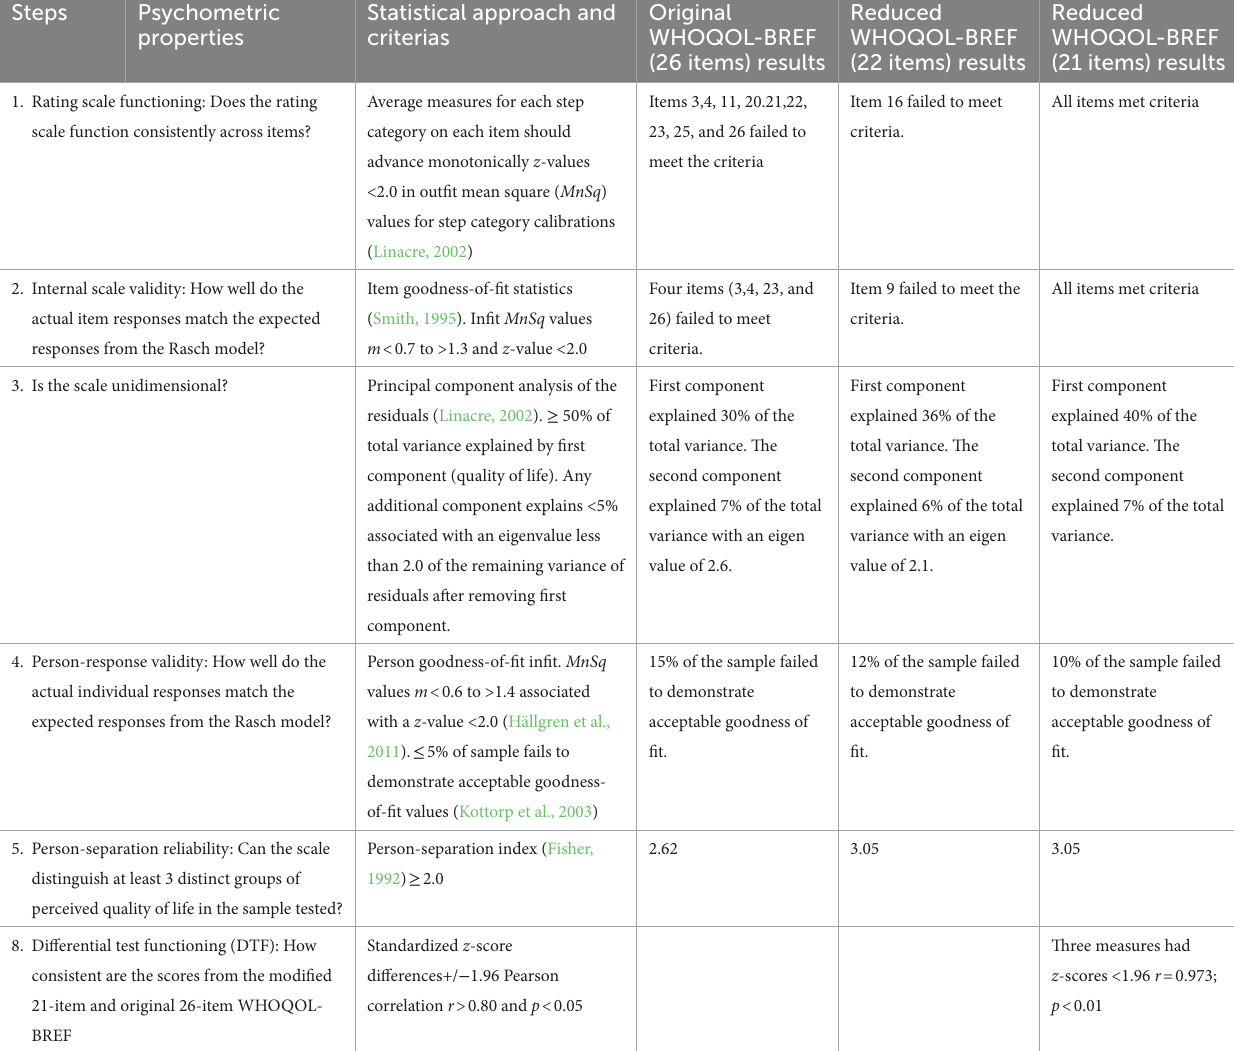
TABLE 3 Psychometric properties of the WHOQOL-BREF